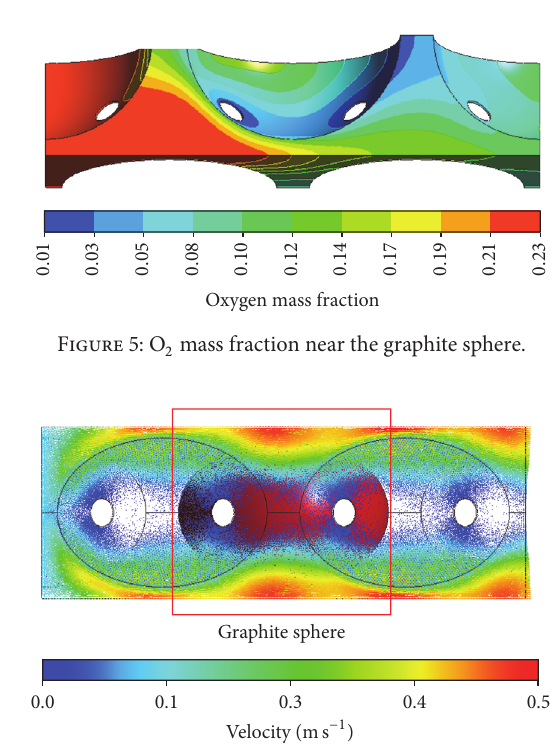
Figure 6: Flow field around the graphite